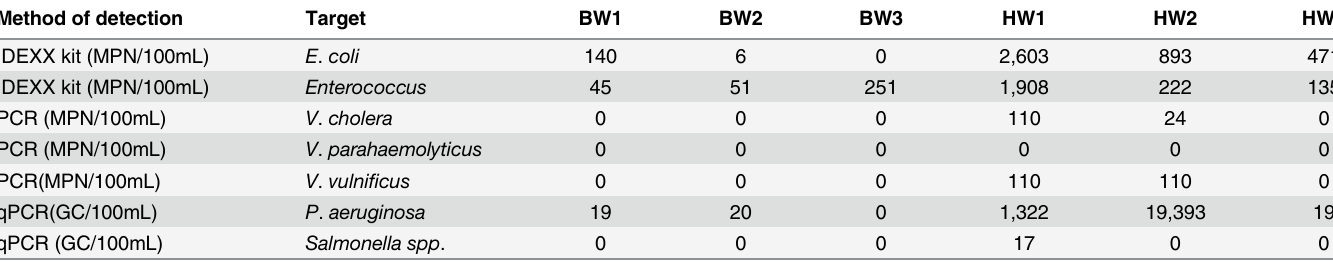
Table 4. Indicator organism measurements in ballast and harbor waters using IDEXX kits and qPCR methods. Method of